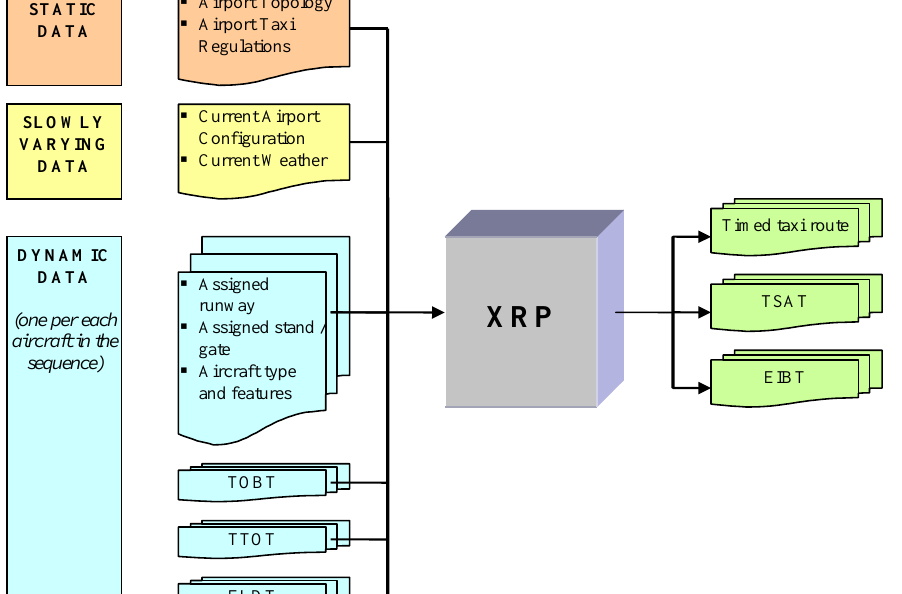
Figure 3. Taxi route planner input/output interface. XRP, Taxi Route Planner.